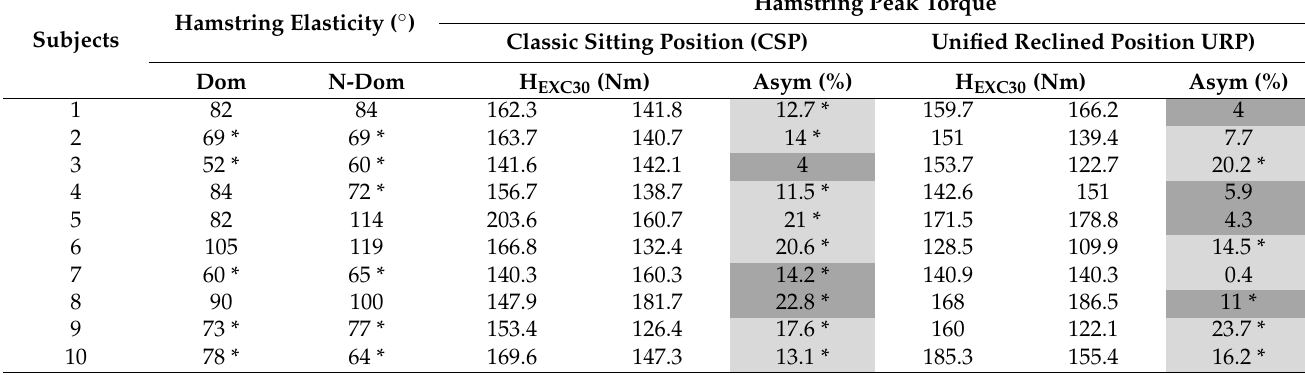
Table A1. Individual values of the hamstring muscles elasticity and eccentric PT in knee extension at 30 ◦ /s